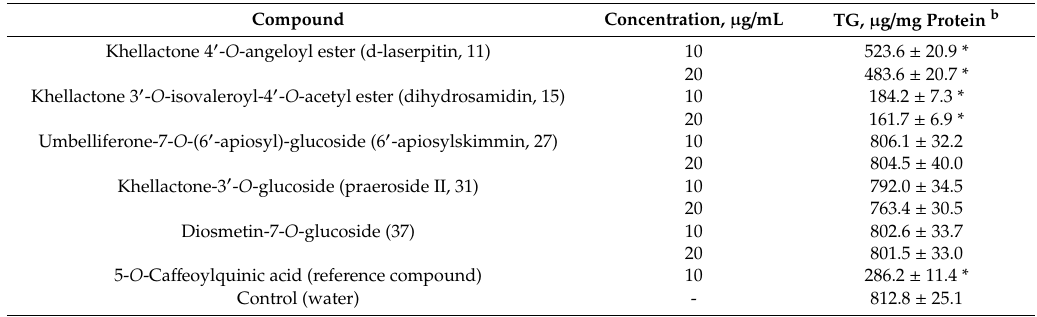
Table 4. Triacylglycerol (TG) content in 3T3-L1 adipocytes after incubation with pure compounds a